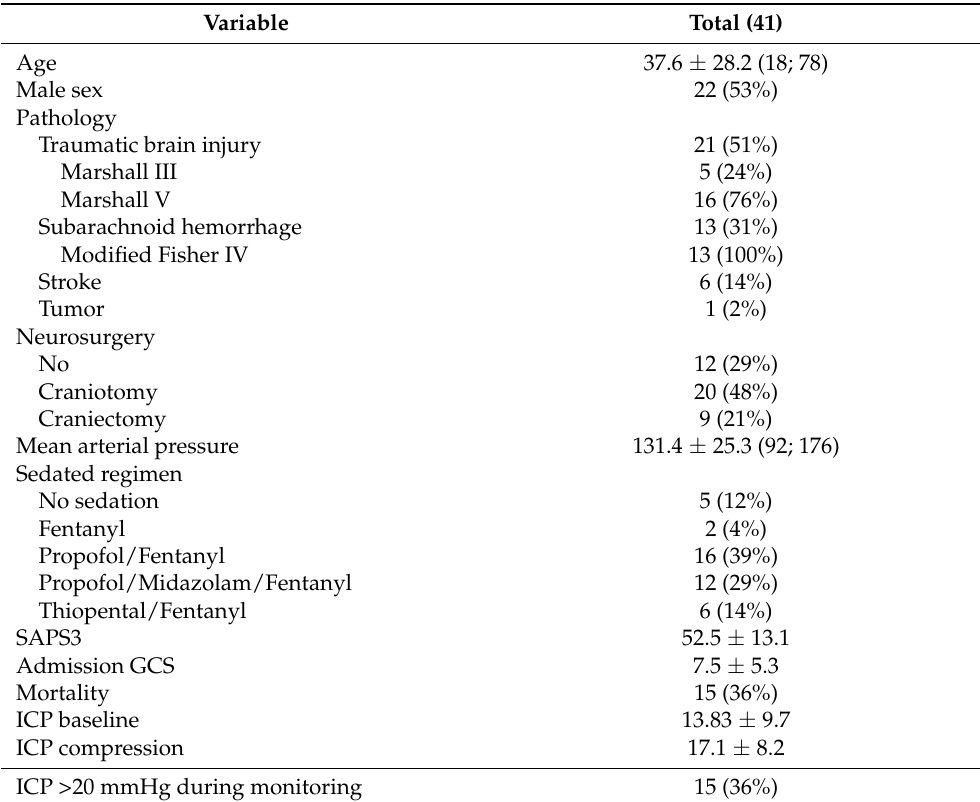
Table 1. Continuous variables are presented as mean ± standard deviation (min; max). Categorical variables presented as n (%). SAPS3: simplified acute physiologic score 3, ICP: intracranial pressure, GCS: Glasgow coma